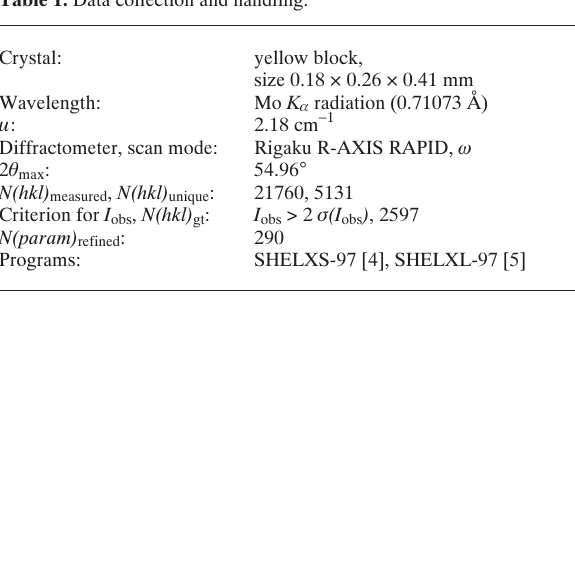
Table 2. Atomic coordinates and displacement parameters (in Å 2 ) . Table 1. Data collection and